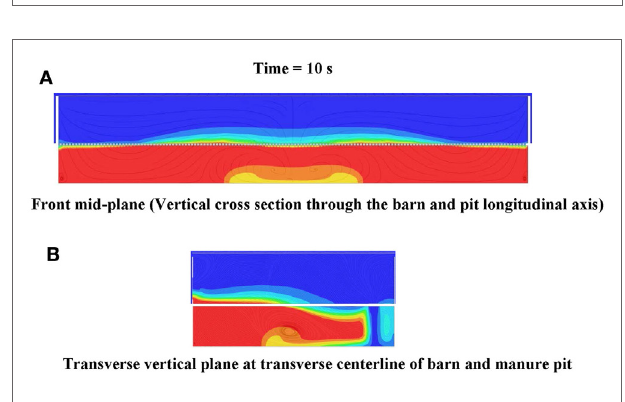
FIgURe 15 | Frames of (A) front mid-plane and (B) transverse vertical plane at centerline of barn and pit cut plot animations of hydrogen sulfide concentration 10 s after commencement of pit ventilation for case Study 2: cross-ventilated barn above slotted-covered manure pit (see Figure 11 for color legend for hydrogen sulfide) .